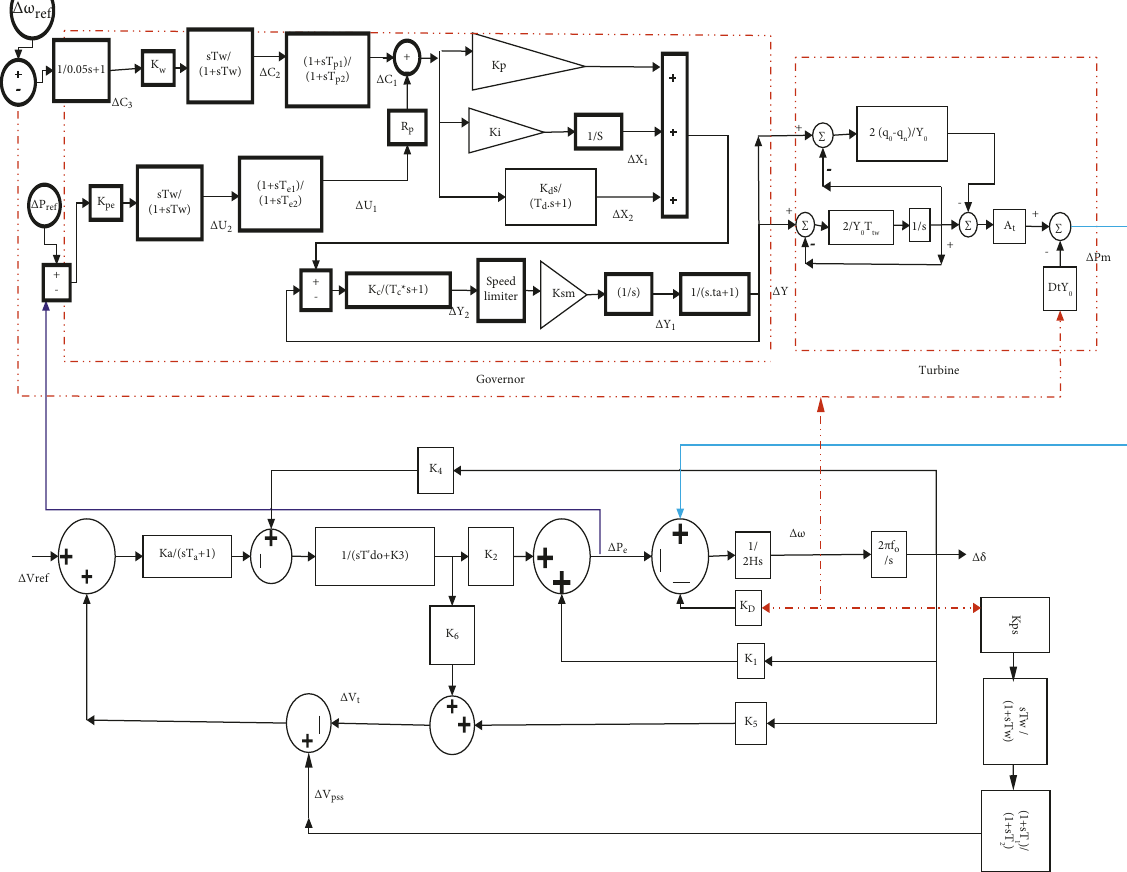
Figure 5: Small signal model of PSHPP with proposed control